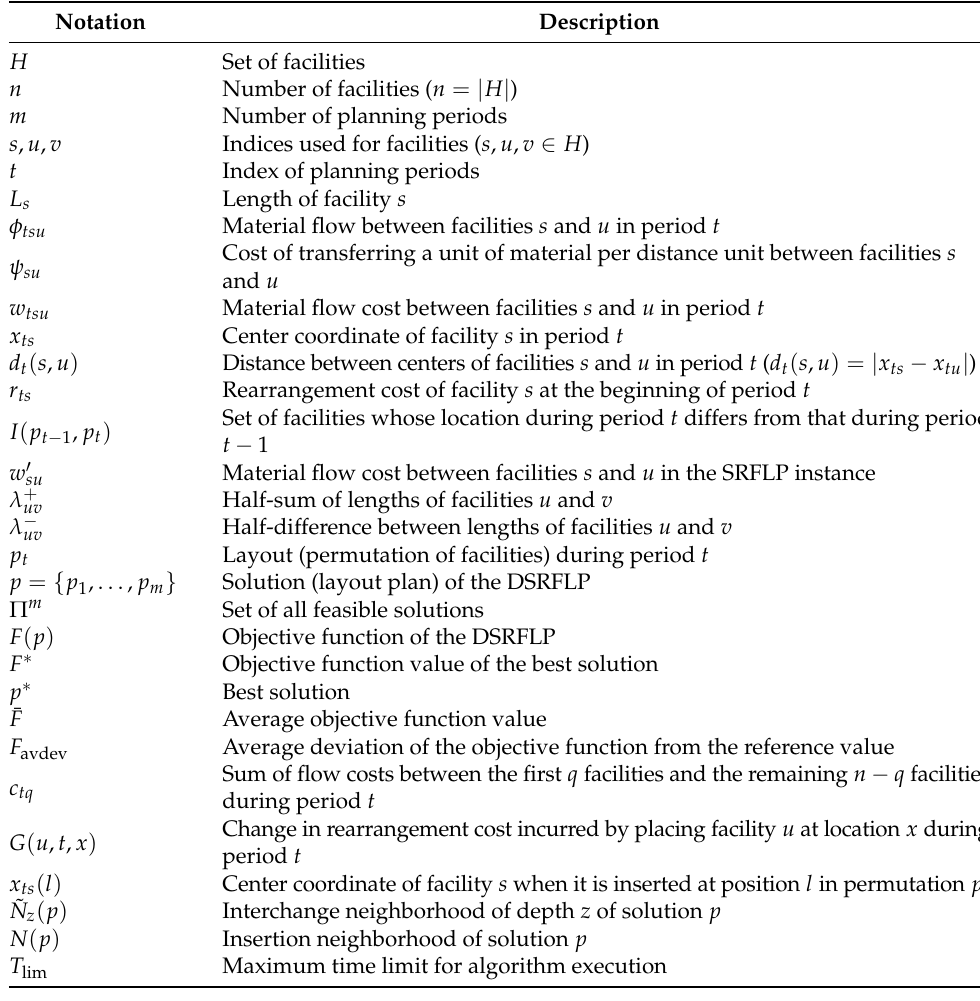
Table 1. Main notations used in this